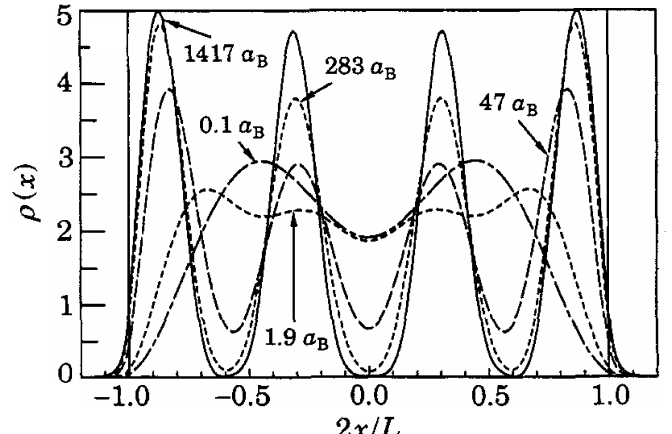
Figure 2. Electron density, n units 1/ L , corresponding to four electrons on a segment, as a function of position ( x axis) and interaction strength (increasing r s corresponds to stronger interactions). The transition between two and four peaks can be clearly seen. Figure adapted from